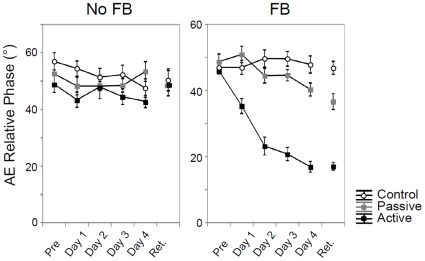
Performance of absolute error of relative phase across days.Absolute error (AE) of the required relative phase (90) in degrees (°) across practice for each group in the absence (left) and presence of augmented feedback in the form of a Lissajous plot (right). Error bars represent SE of mean.